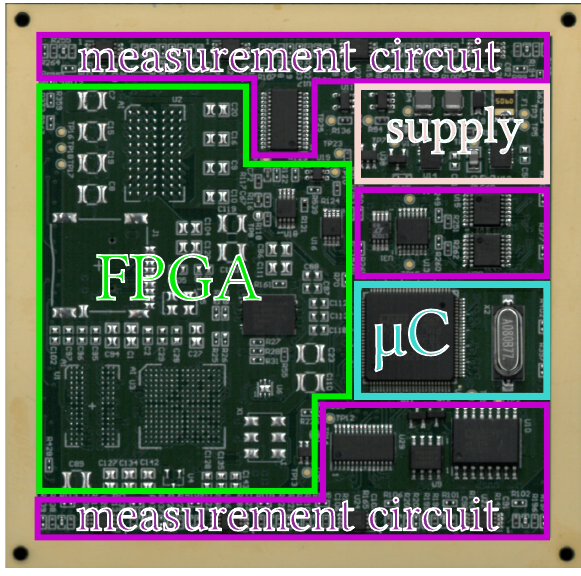
Figure 12: Top side of the test vehicle’s inner security perimeter showing various system components. Please note, the components for the FPGA have not been